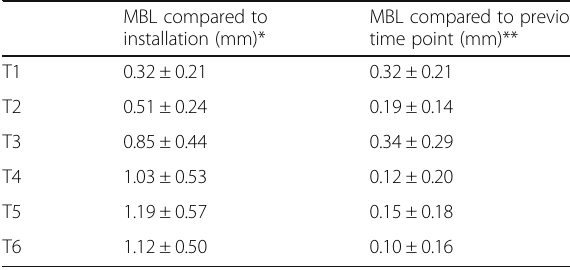
Table 4 Marginal bone loss (MBL) of dental implants placed on the augmented bone at evaluated time